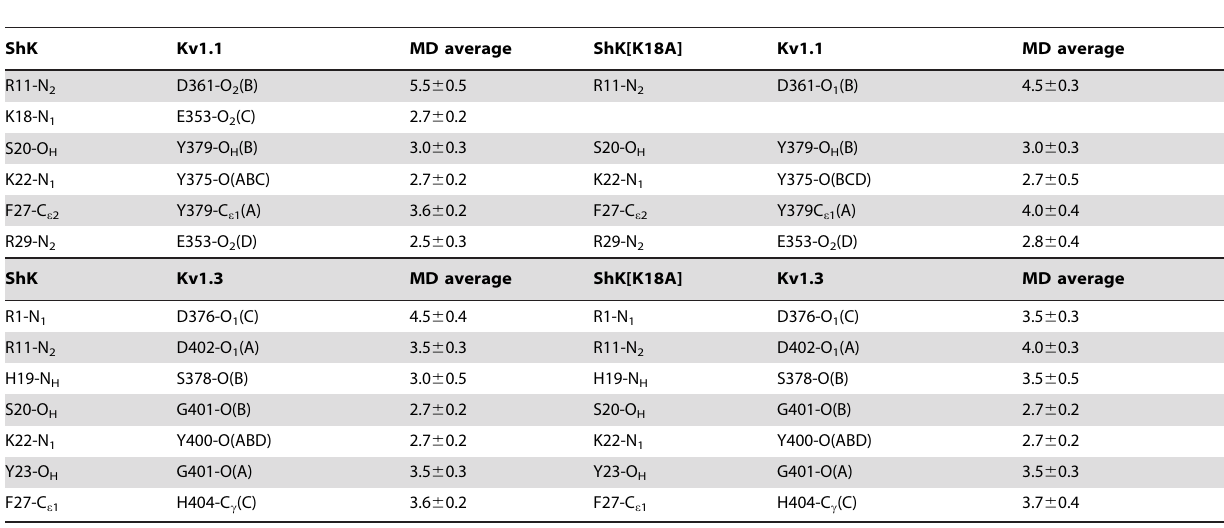
Table 1. Comparison of the strongly interacting pair distances in the ShK–Kv1.x complexes with those in the ShK[K18A] –Kv1.x